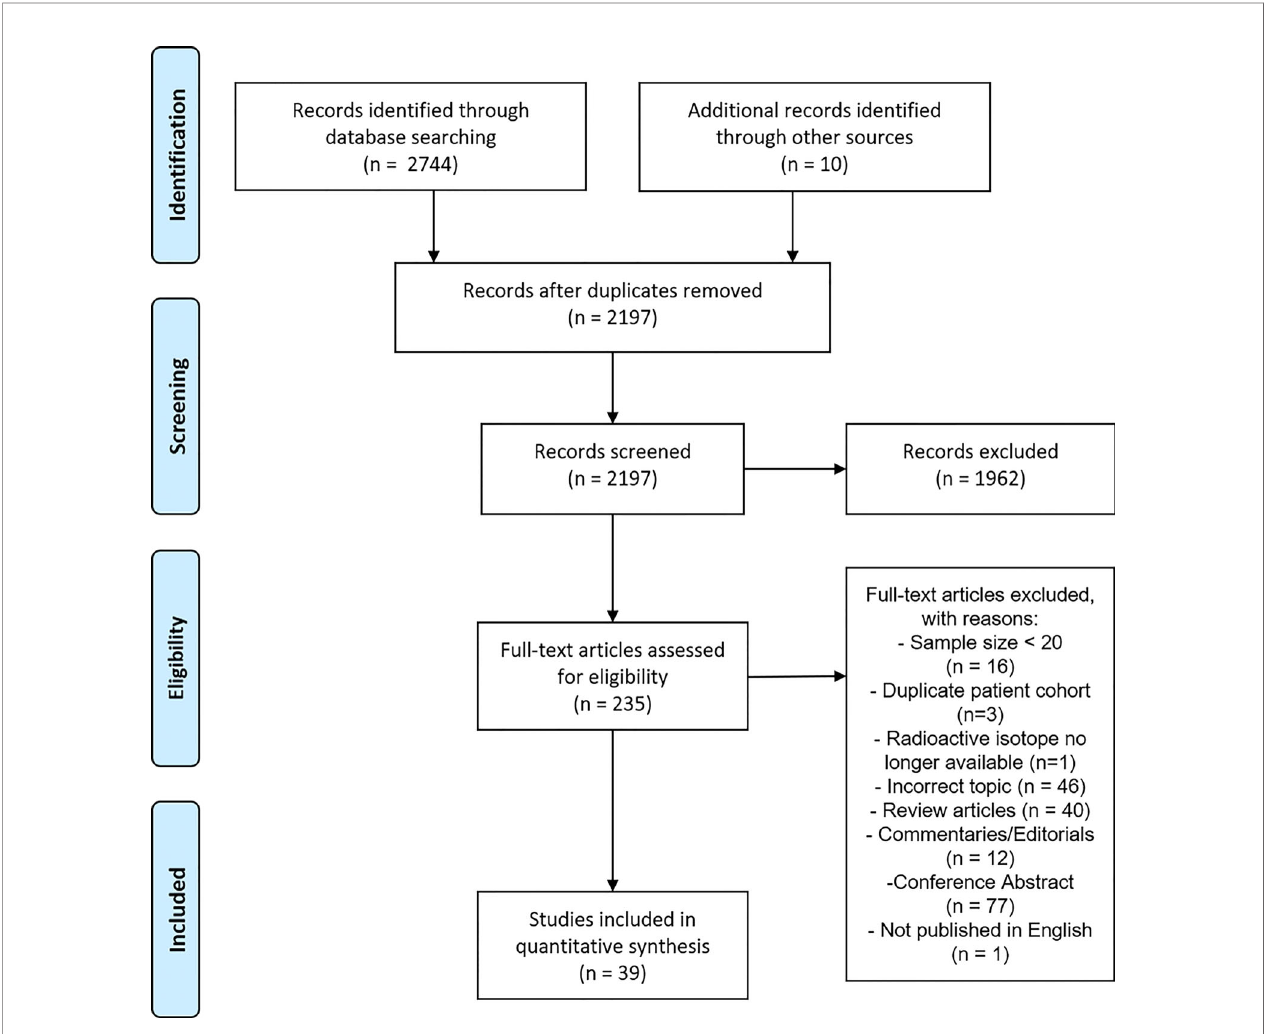
FIGURE 1 | PRISMA fl ow chart of literature